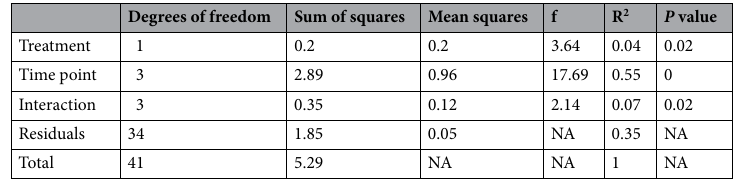
Table 1. Results of PERMANOVA on Bray–Curtis distances of microbiota data.